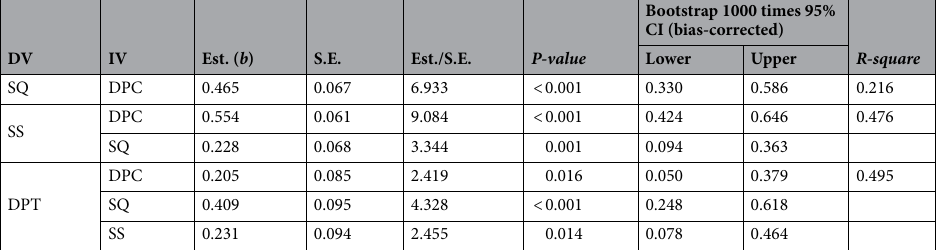
Table 4. Research model regression weight and hypothesis. DPC doctor–patient communication, SQ service quality, SS service satisfaction, DPT doctor–patient trust, S.E. standard error, DV dependent variable, IV independent variable, CI confidence interval.